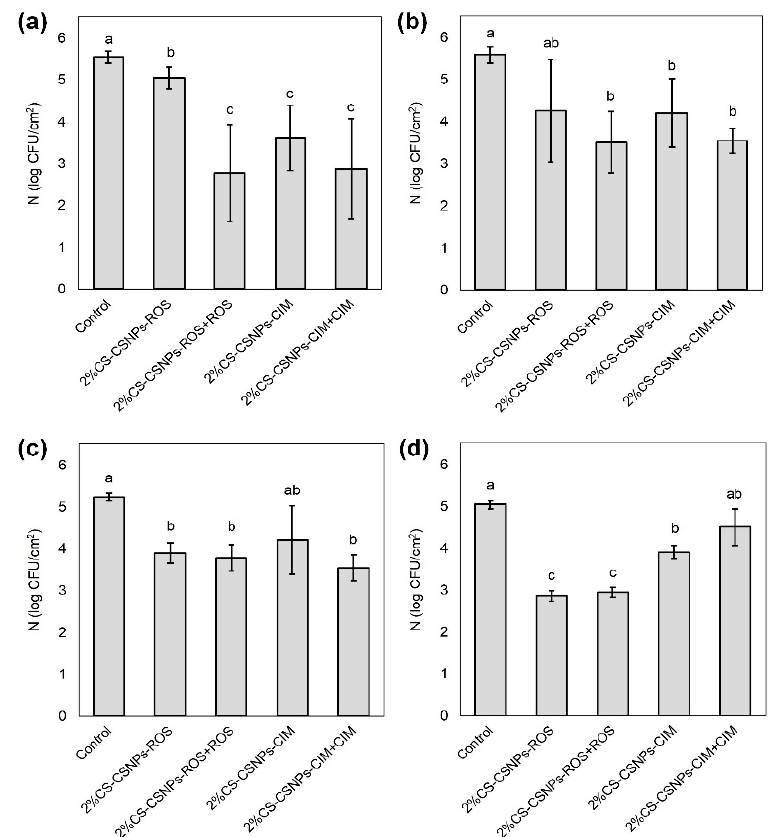
Figure 6. Antimicrobial activity of functionalised whey-based laminates against Staphylococcus aureus ( a ), Escherichia coli ( b ), Aspergillus flavus ( c ) and Penicillium verrucosum ( d ). Different letters indicate significant difference ( P < 0.05).